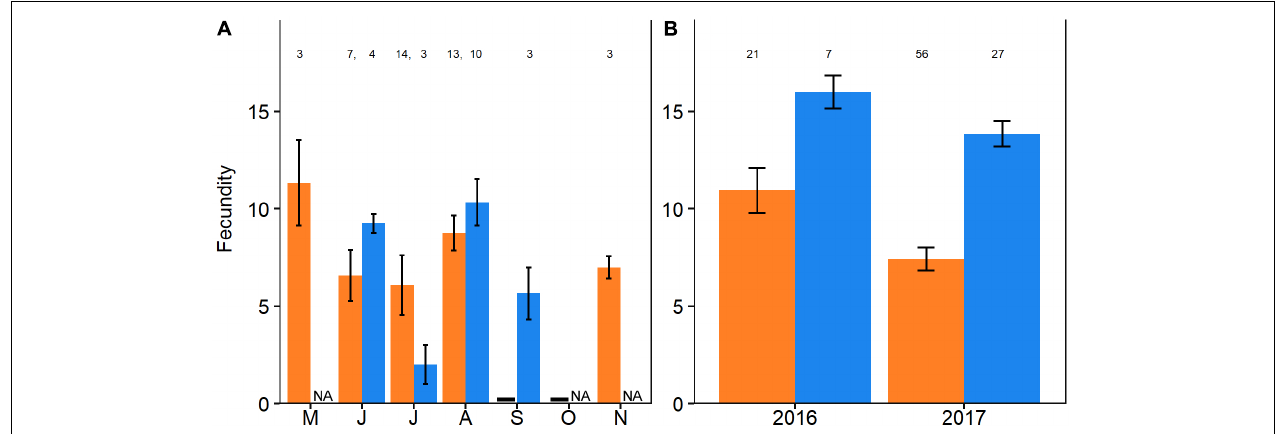
FIGURE 8 | Number of mature oocytes per polyp of upper MCE (orange) and shallow-water (blue) (A) Ovabunda spp. and (B) Rhytisma fulvum fulvum during peak breeding season of 2016 and 2017. Number of examined polyps per season above x-axis. NA represent months in which no sample was analyzed.